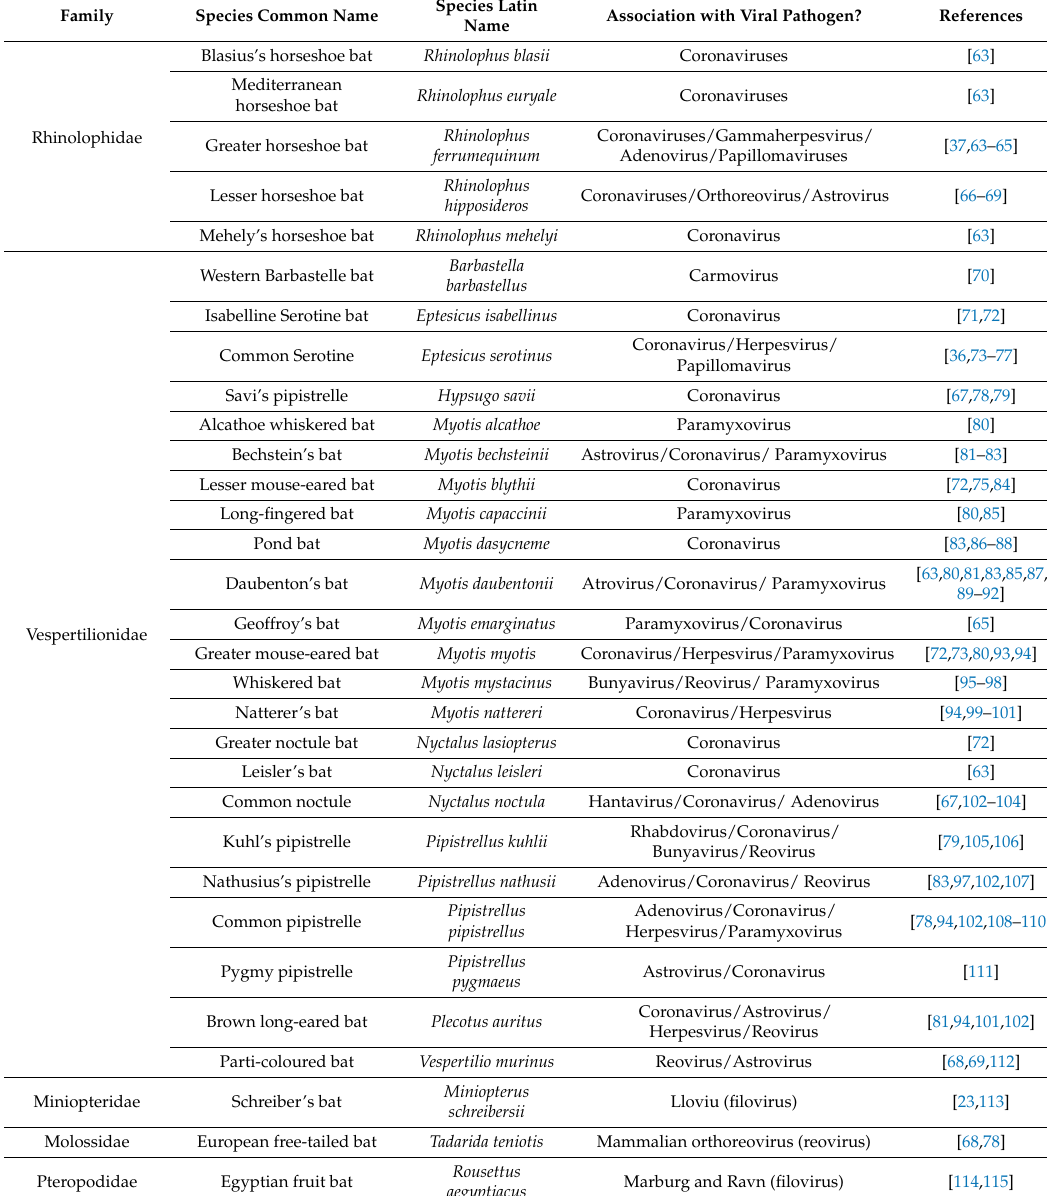
Table 3. Association of non-lyssavirus zoonoses with bat species in the EU.